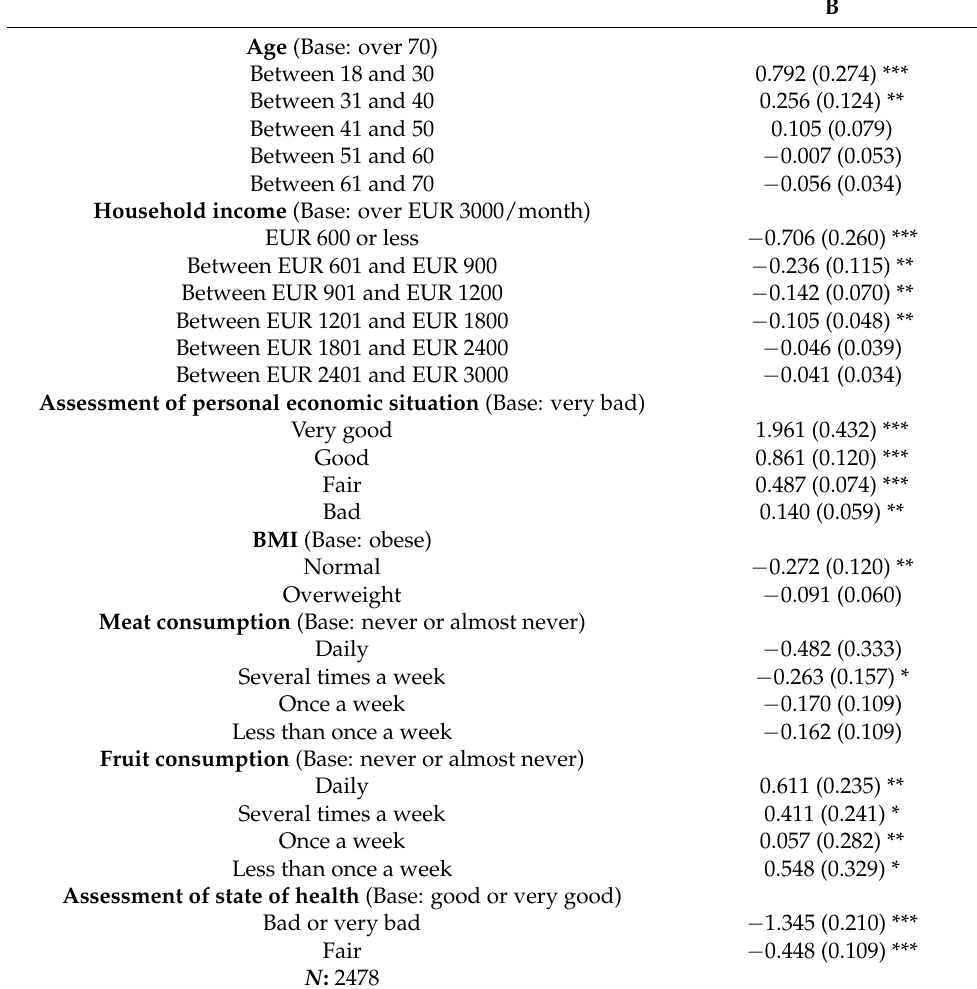
Table 4. Multiple linear regression. Scale of general satisfaction with life